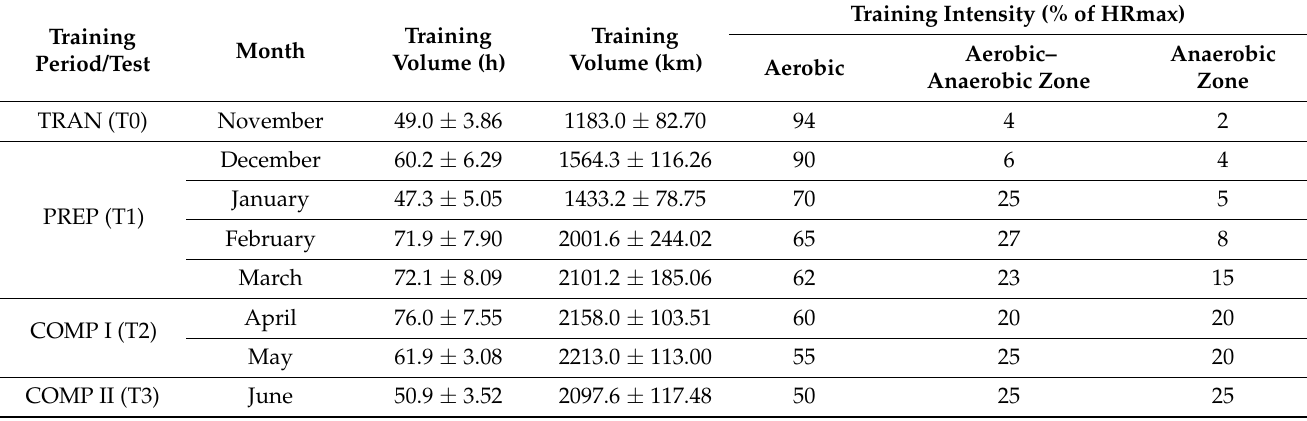
Table 2. The monthly average values of training loads (volume and intensity, nature of effort, training strategies, nature of cycling training, aerobic and anaerobic training